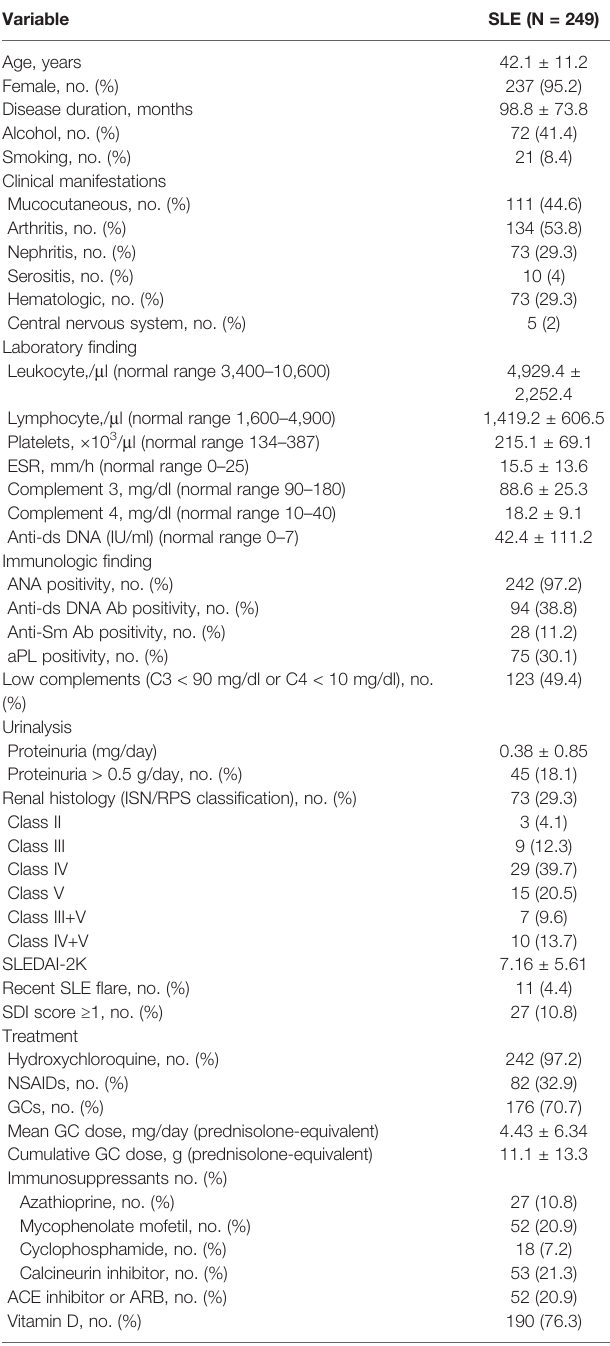
TABLE 1 | Demographic and clinical characteristics of patients with systemic lupus erythematosus (SLE) and healthy controls.